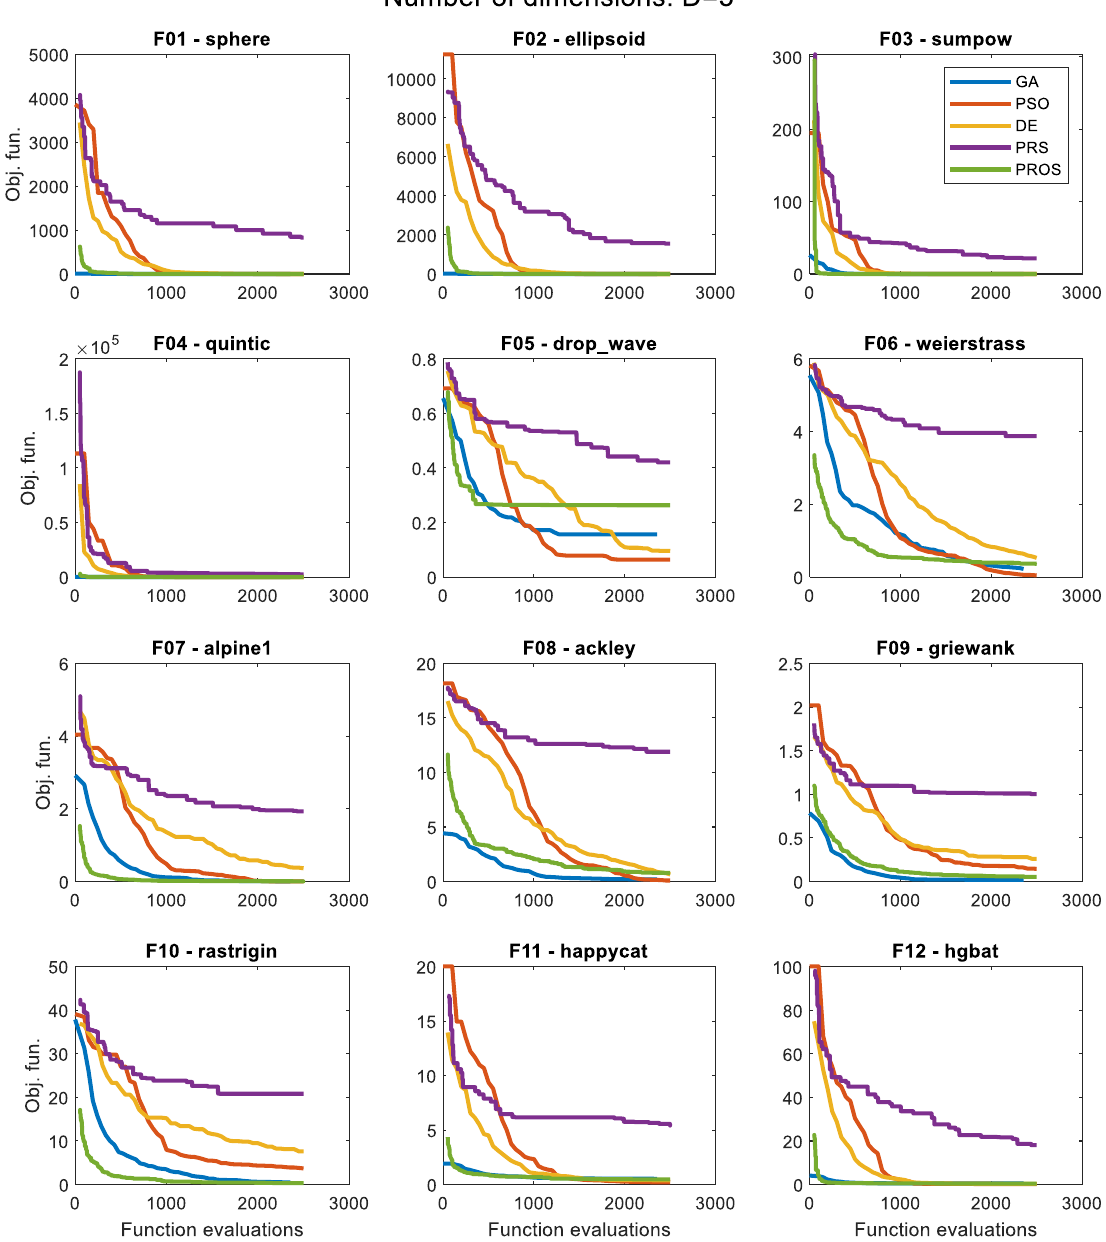
Figure 5. Convergence history of the various optimizers for 5 dimensions ( D = 5), for all 12 objective functions (average of 10 runs).